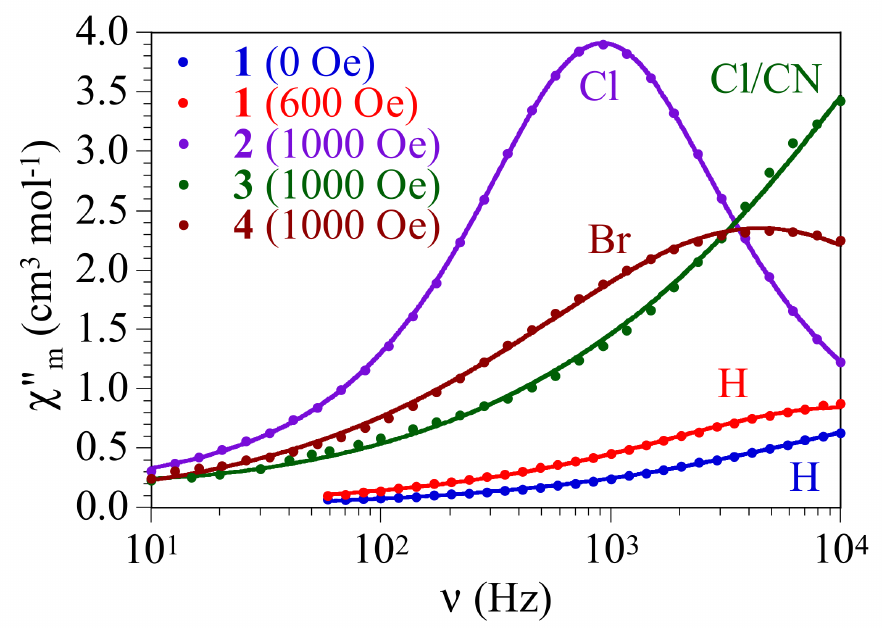
Figure 12. Frequency dependence of χ (cid:48)(cid:48) m for compounds 1 (X = H; H dc = 0 and 600 Oe), 2 (X = Cl; H dc = 1000 Oe), 3 (X = Cl/CN; H dc = 1000 Oe) and 4 (X = Br; H dc = 1000 Oe) at 1.9 K. Solid lines are the best fit to the Debye